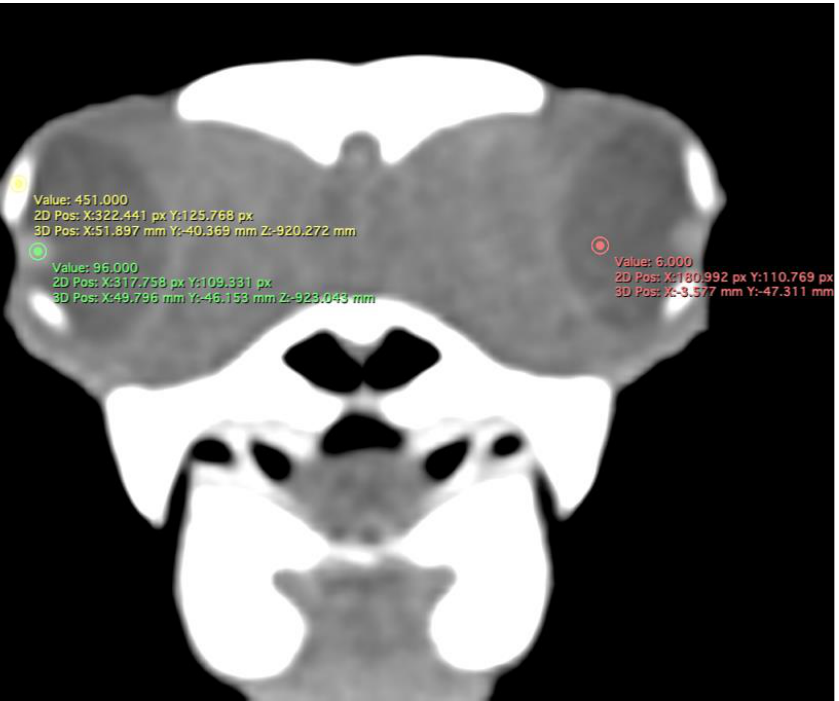
Figure 4. Transverse CT image in soft tissue window of the C. caretta head. Regions of interest (ROI) indicating the areas used to measure mean attenuation in Hounsfield Units (HU) of the lens (green circle), sclerotic ring (yellow circle), and vitreous humour (red circle).